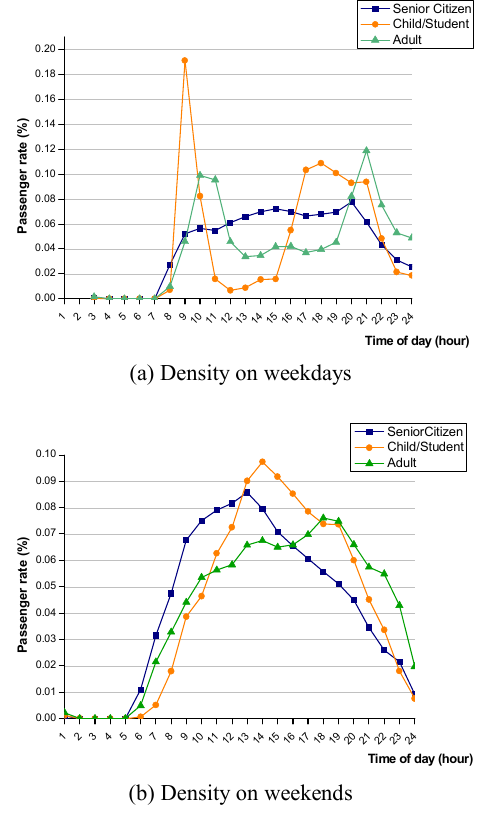
Figure 2. Public transit temporal patterns among the three categories in different